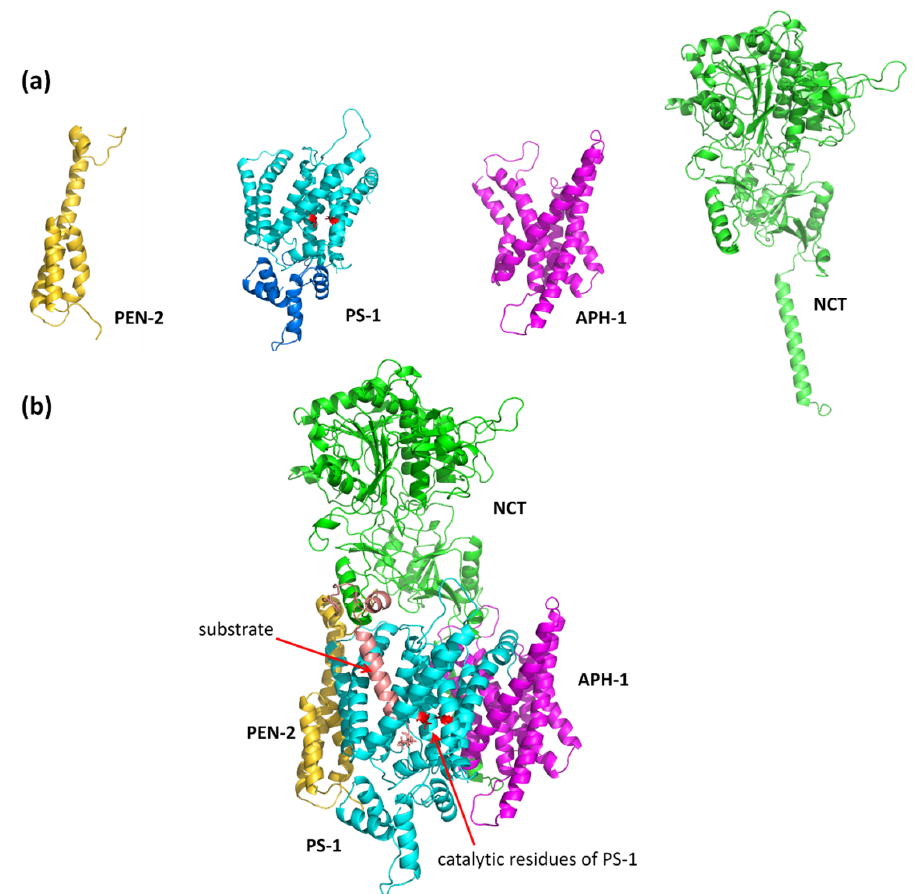
Figure 2. The structure of γ-secretase. ( a ) The individual components of the complex. PS-1 is shown with the modeled long cytosolic loop (residues 288–378, colored in blue) located between helices TM6 and TM7 that contains catalytic residues. The catalytic residues are shown in red. ( b ) The whole complex of γ-secretase together with docked substrate Aβ. Colors of proteins: PS-1 in cyan, APH-1 in purple, NCT in green, PEN-2 in yellow, and the Aβ substrate in salmon.